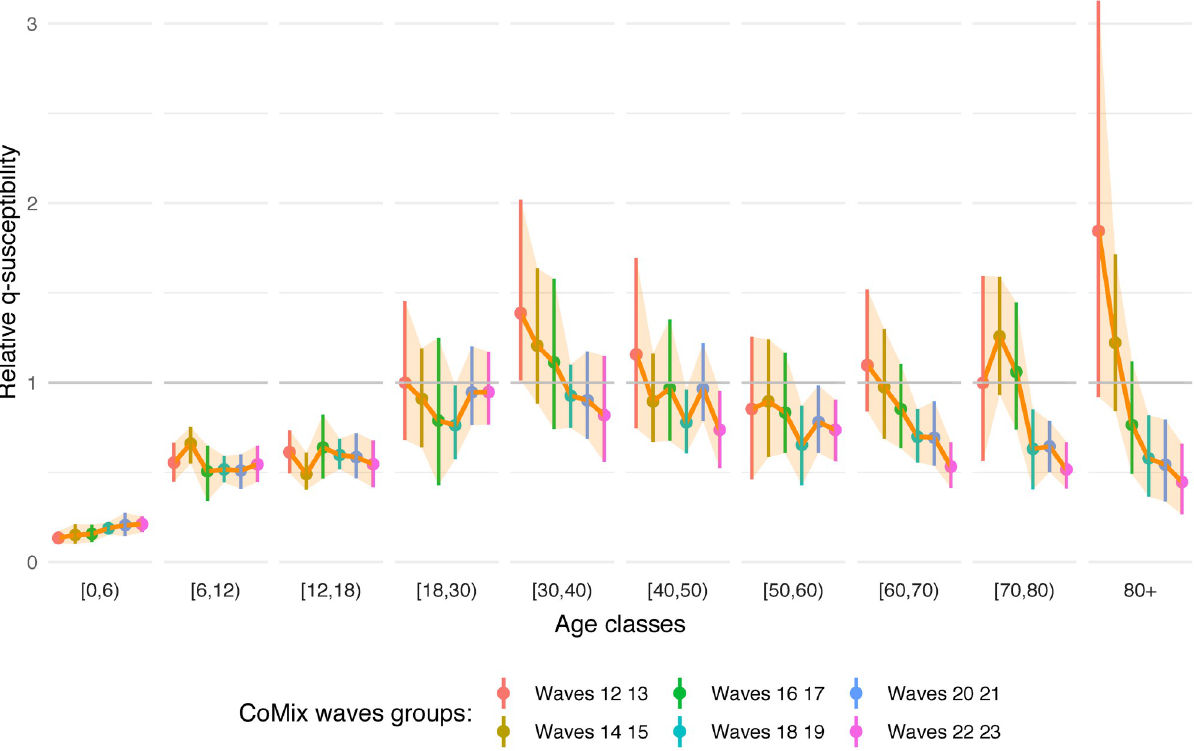
Fig 4. Estimated relative q -susceptibility over time. The estimation of q -susceptibility is performed by age class and over time on groups of two consecutive CoMix waves, corresponding to a period of 4 weeks, under an assumption on age-specific infectiousness (0.54, 0.55, 0.56, 0.59, 0.7, 0.76, 0.9, 0.99, 0.99, 0.99). Dots represent means and bars represent 95% percentile (nonparametric) bootstrap-based confidence intervals.